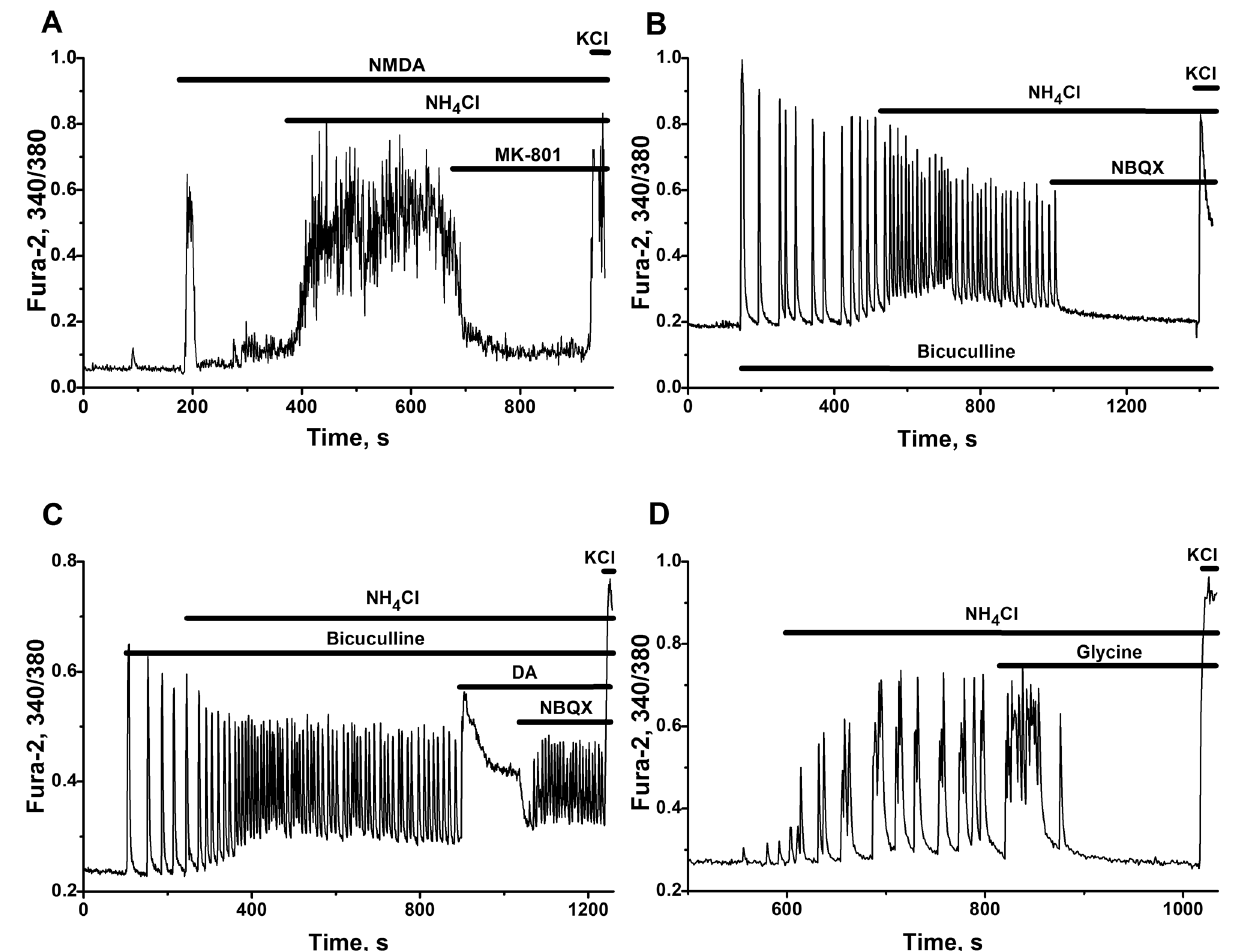
Fig 8. The involvement of ionotropic glutamate, GABA and glycine receptors in the activation of neural network by ammonium ions. Ca 2+ responses of representative neurons (81% of cells on Fig A and 90 – 95% of cells on Fig B – D in networks monitored) were registered in cultures 12 – 16 DIV. All other abbreviations and descriptions as on Fig 1. (A) Suppressant effect of the antagonist of NMDA-receptors MK-801 (20 μ M) on neuronal network accelerated by 8 mM NH 4 Cl in the presence of NMDA (10 μ M). N = 97. (B) The antagonist of AMPA/Kainate receptors NBQX (20 μ M) cancelled Ca 2+ oscillations accelerated by 8 mM NH 4 Cl in the presence of GABA (A)-receptors antagonist bicuculline (20 μ M). N = 124. (C) Excessive activation of AMPA/ kainate receptors by domoic acid (DA, 200 nM) suppresses oscillatory regime in whole network disinhibited by bicuculline (20 μ M) and further activated by NH 4 Cl (8 mM). Added NBQX (20 μ M) renewed high-frequency oscillations, previously destroyed by DA. N = 132. (D) 100 μ M glycine damped Ca 2+- oscillations induced by 8 mM NH 4 Cl in previously silent network. N =